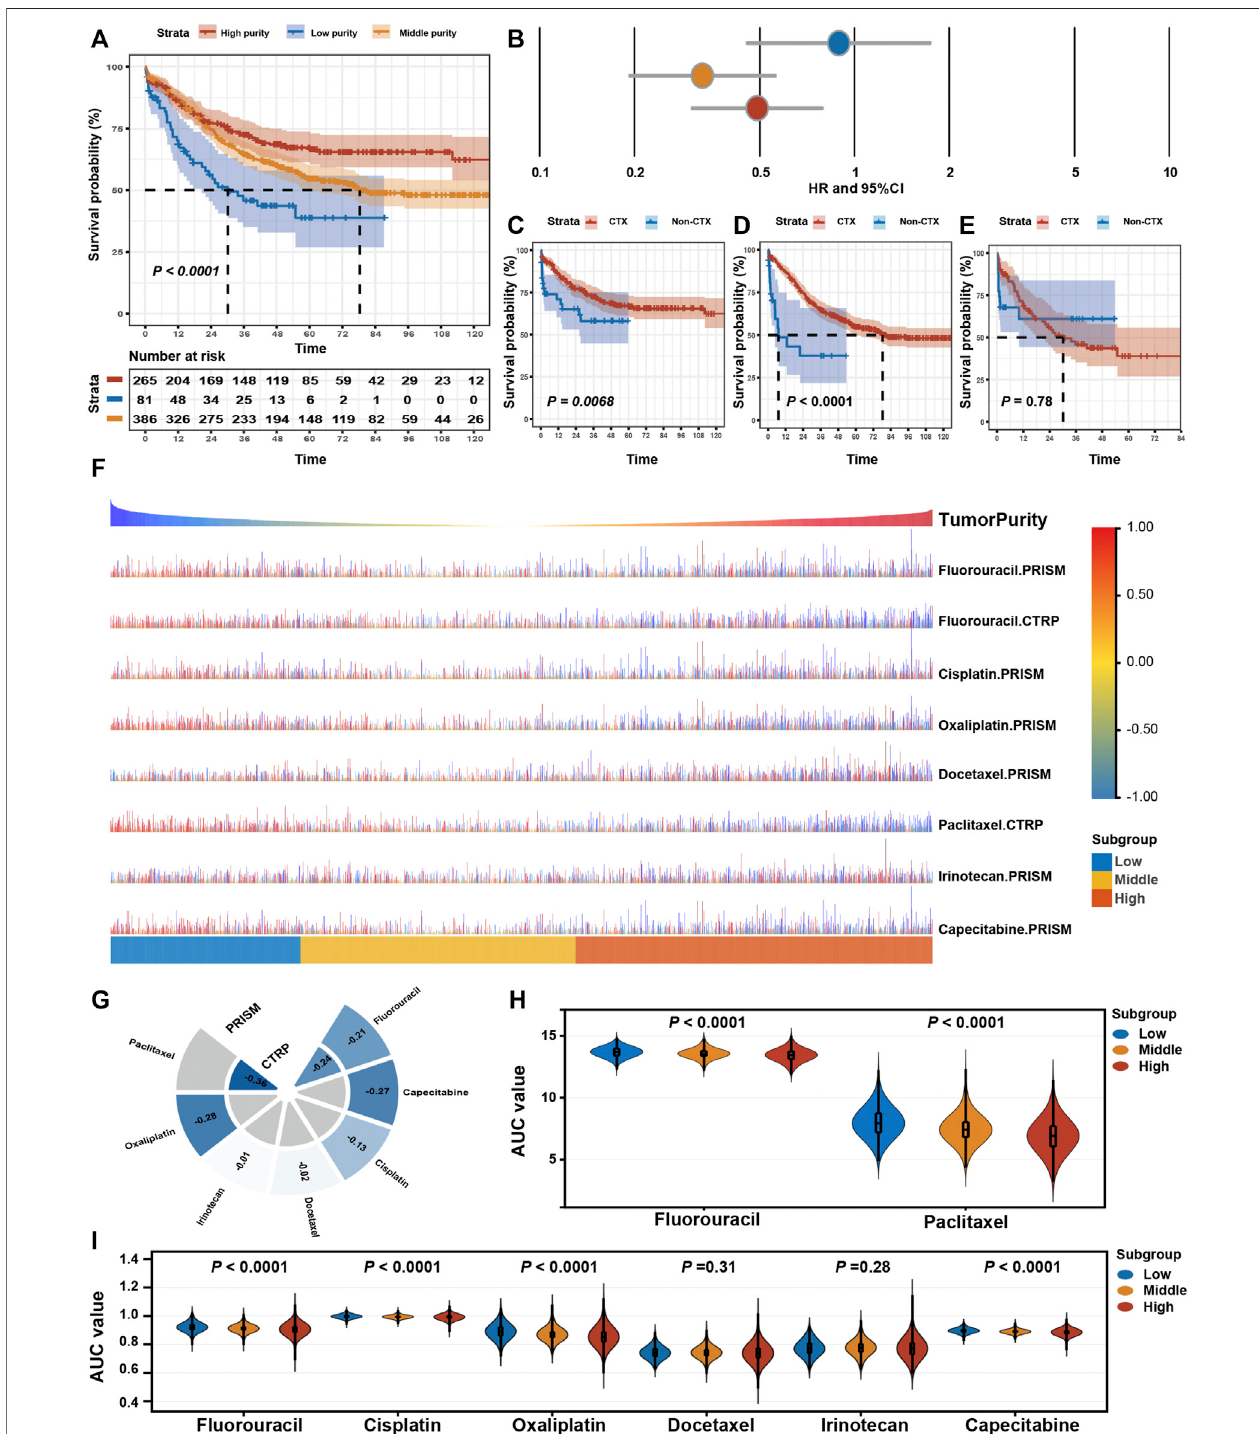
FIGURE 6 | Drugresponsefeaturesoftumourpurityforchemotherapyofgastriccancer. (A) Kaplan – Meiercurvesforoverallsurvival(OS)amongdifferentpuritysubgroupsof patients who received adjuvant chemotherapy. p -values were obtained using the log-rank test. The + symbols in the panels indicate censored data. (B) Subgroup analyses for adjuvantchemotherapyusingtheCoxproportionalhazardsregressionmodel.Thelinesrepresentthe95%con fi denceintervalsofthehazardratios. (C – E) Kaplan – Meiercurvesfor OS among patients who received adjuvant chemotherapy (CTX) and those who did not (non-CTX) in the (C) high-purity, (D) middle-purity and (E) low-purity subgroups. p -valueswereobtainedusingthelog-ranktest.The+symbolsinthepanelsindicatecensoreddata. (F) Thepredictedareaunderthecurve(AUC)valueofchemotherapeuticdrugsfor eachpatient. (G) TheSpearmancorrelationcoef fi cientbetweentumourpurityandAUCvalues. (H,I) DifferencesinthepredictedAUCvalueforchemotherapeuticdrugsbasedonthe (H) CTRPand (I) PRISMdatabasesamongthethreesubgroups.Theupperandlowerendsoftheboxesrepresenttheinter-quartilerangeofvalues.Thehorizontalwidthoftheviolin represents the data density. p -values were obtained via the Kruskal – Wallis test. CTX, adjuvant chemotherapy; non-adjuvant chemotherapy, non-CTX.